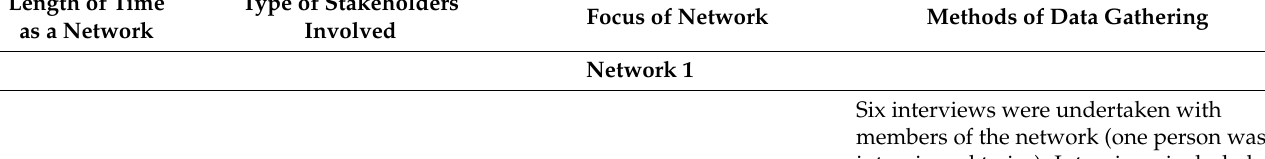
Table 1. Characteristics of the three networks studied and the methods the researchers used for data gathering. Length of